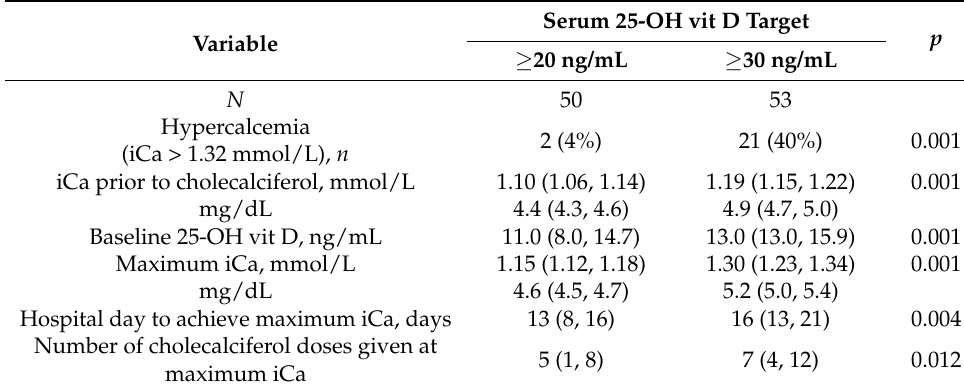
Table 4. Pathogenesis of